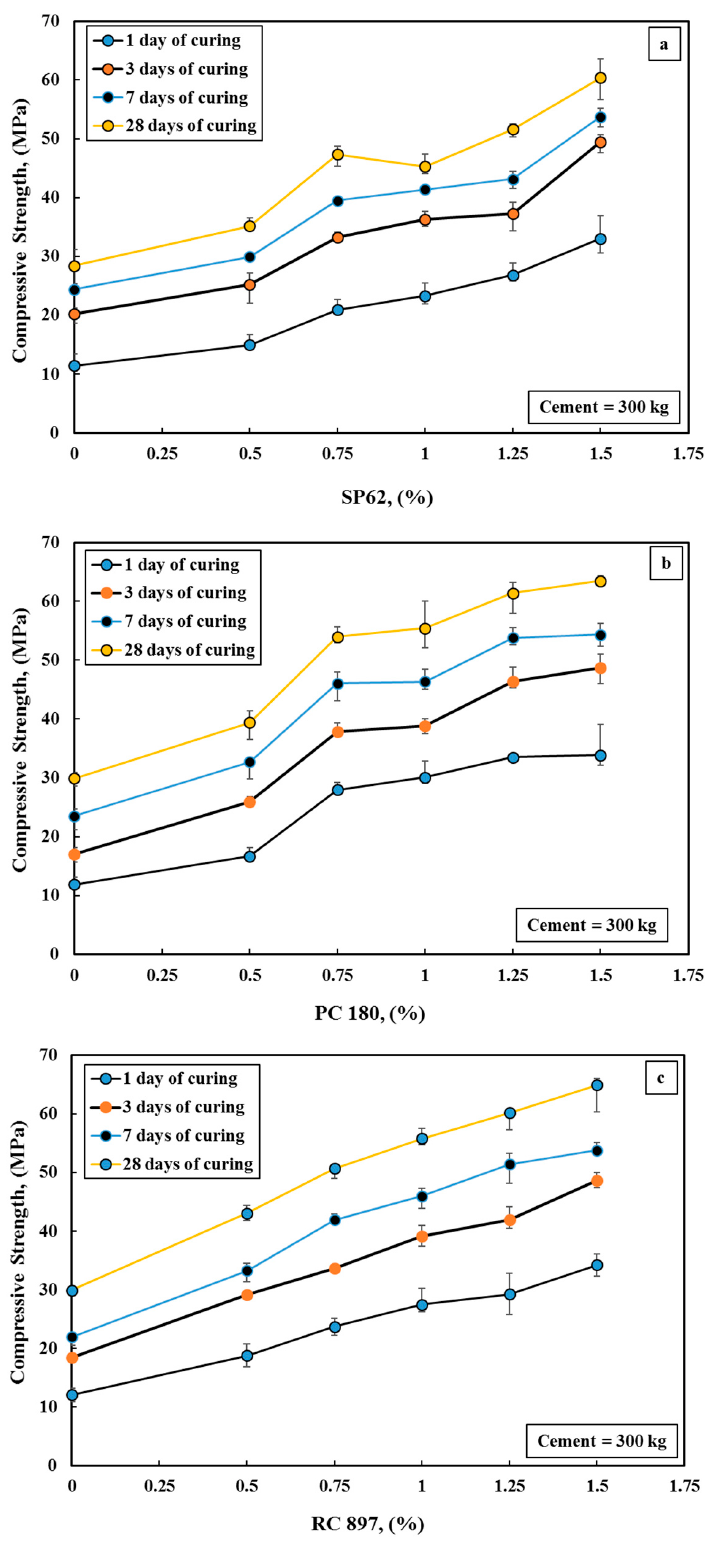
Figure 3. Additives’ impact on the concrete compressive strength using 300 kg cement ( a ) SP62, ( b ) PC 180, and ( c ) RC 897.